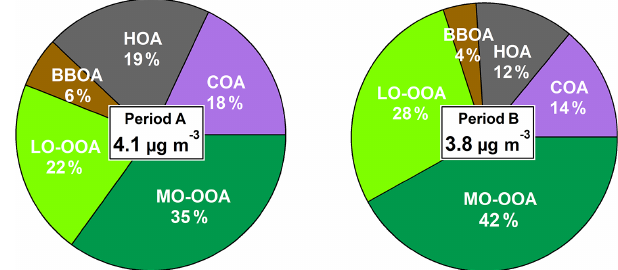
Figure 2. Average OA source apportionment for periods A and B and concentrations of apportioned OA for period A and period